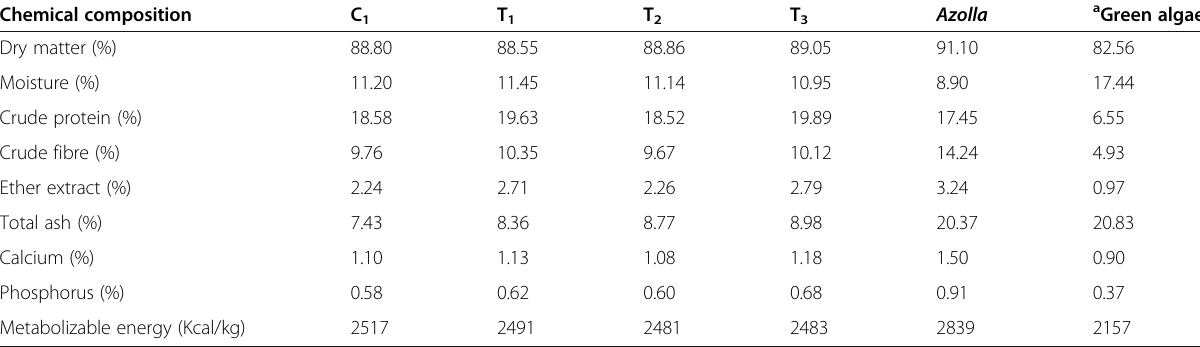
Table 2 Chemical composition of experimental diets, Azolla and green algae ( Ulva lactuca ) Chemical composition C 1